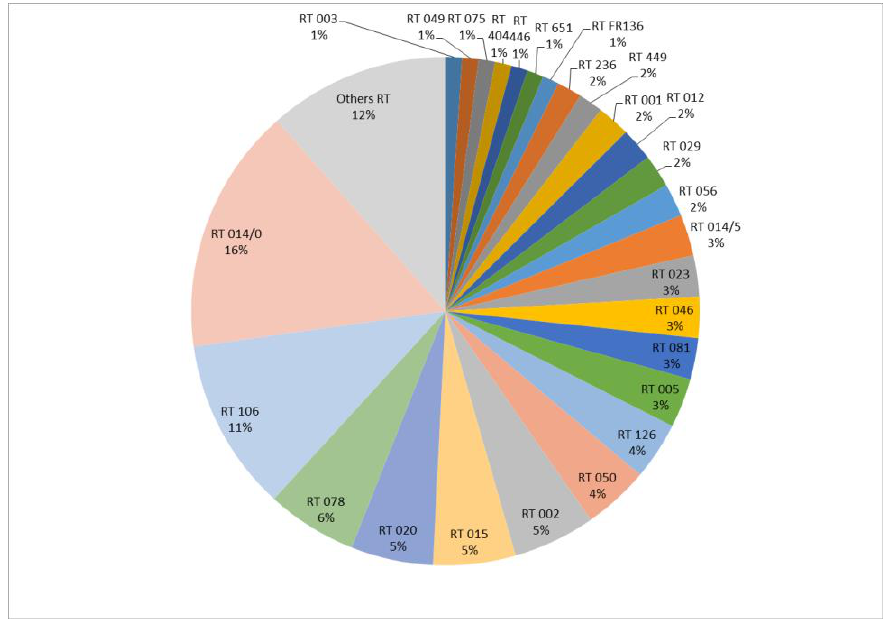
Figure 1. Distribution of PCR-ribotypes (%) (n = 191 isolates). Among the 191 isolates, 22 (11.5%) were isolated from recurrent CDIs. Based on the PCR-ribotyping results, 77% of recurrences (n = 17/22) were considered to be relapses (same RT as the initial episode), with a mean time interval of 52 days (min = 8, max = 140), and 23% (n = 5/22) were re-infections (different RTs), with a mean time interval of 74 days (min = 2, max = 182).